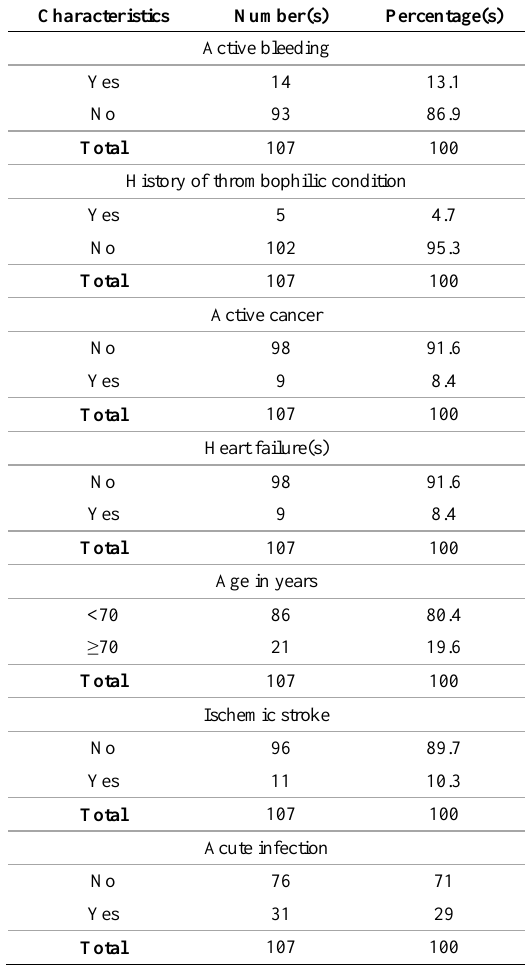
Table 3. Descriptive statistics of Padua prediction score Elements